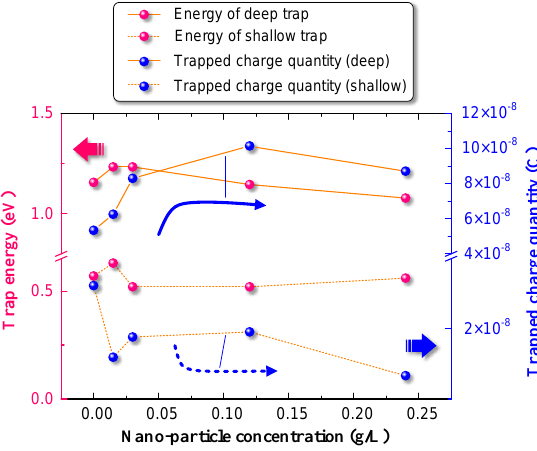
Figure 12. Effects of nanoparticle concentration of the trap parameters.